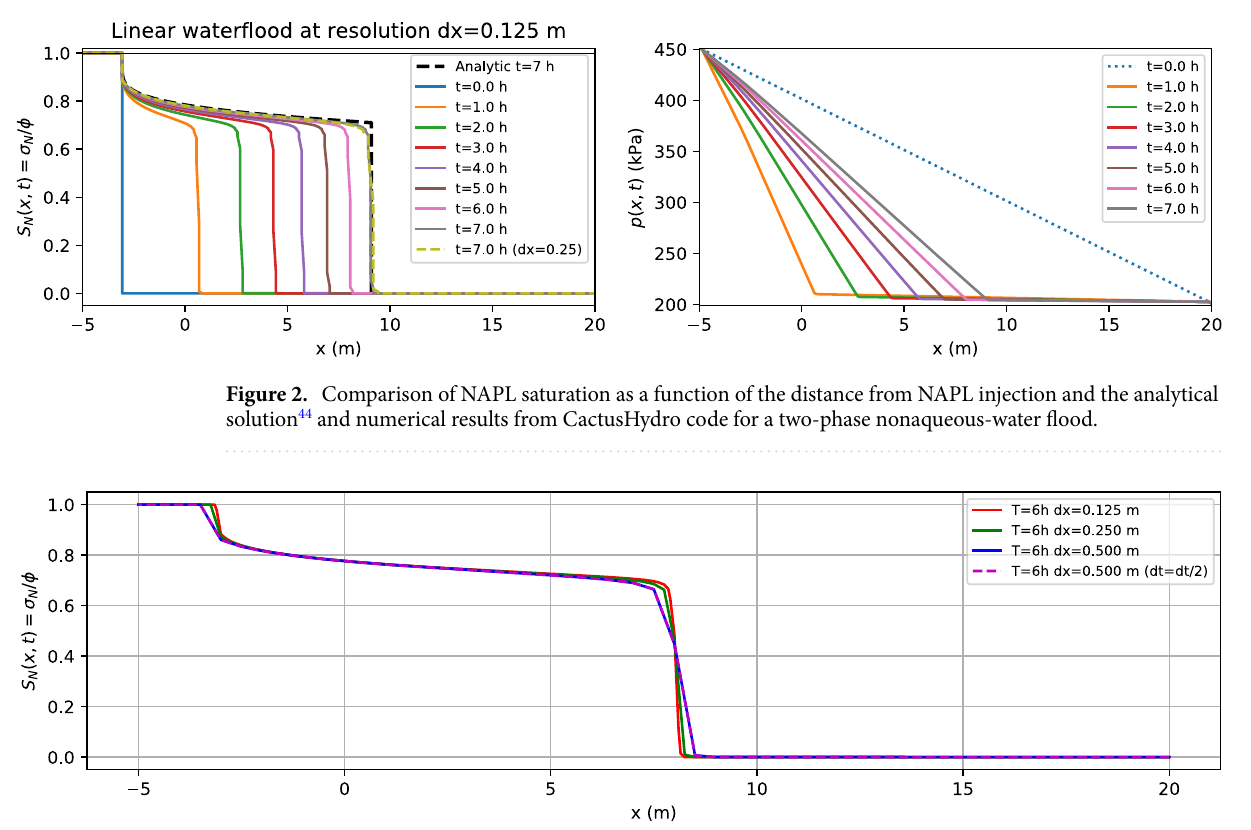
Figure 3. Comparison of NAPL saturation as a function of the distance from NAPL injection and the analytical solution 44 and numerical results from CactusHydro code for a two-phase nonaqueous-water